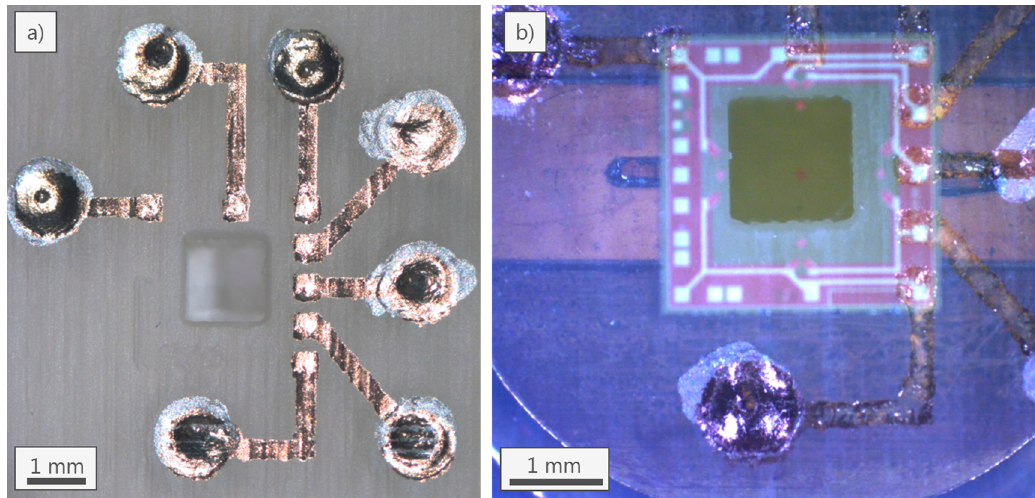
Figure 2. ( a ) 3D- and inkjet-printed package with conductive paths, pads and through-via contacts (without sensor dye); ( b ) Optical image of the alignment and fine placing of the pressure sensor dye on the printed